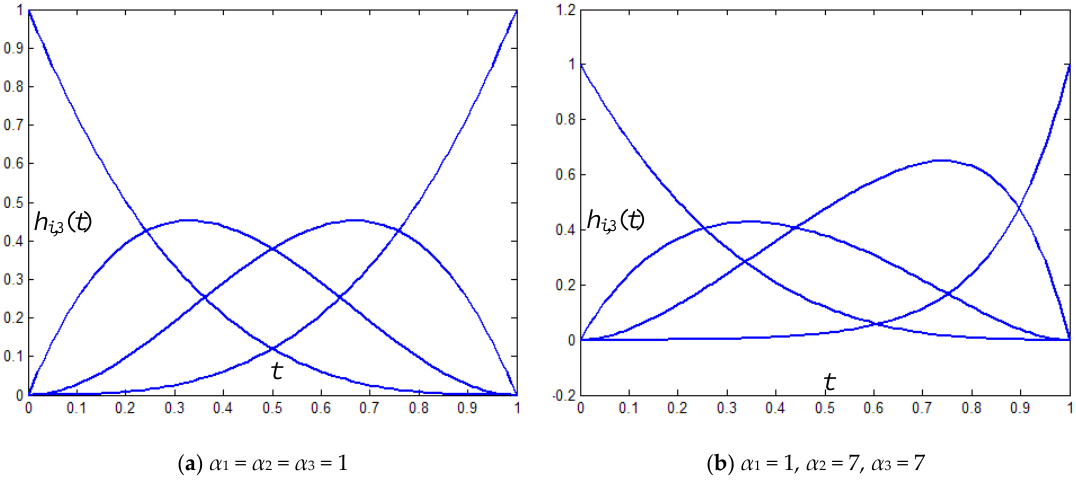
Figure 1. Generalized cubic H-Bézier basis functions.